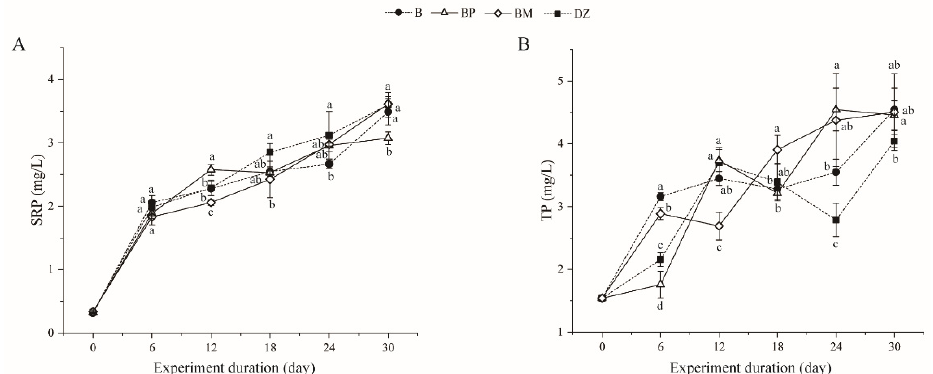
Figure 2. Changes of SPR ( A ) and TP ( B ) in the water of different groups. Note: group B, a single B. pumilus BP-171, was added; the group BP, B. pumilus BP-171, and PHBV were added; the group BM, B. pumilus BP-171, and molasses were added; the group DZ, the control without any probiotics and carbon sources addition. Values with different superscripts on the same day are significantly different among treatments in each figure ( p < 0.05).